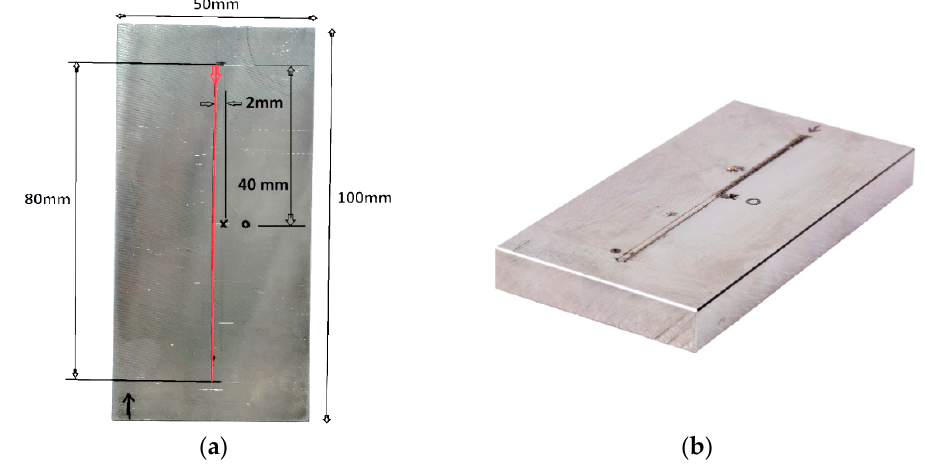
Figure 5. ( a ) Weld track and specimen specification ( b ) single-track deposited sample.